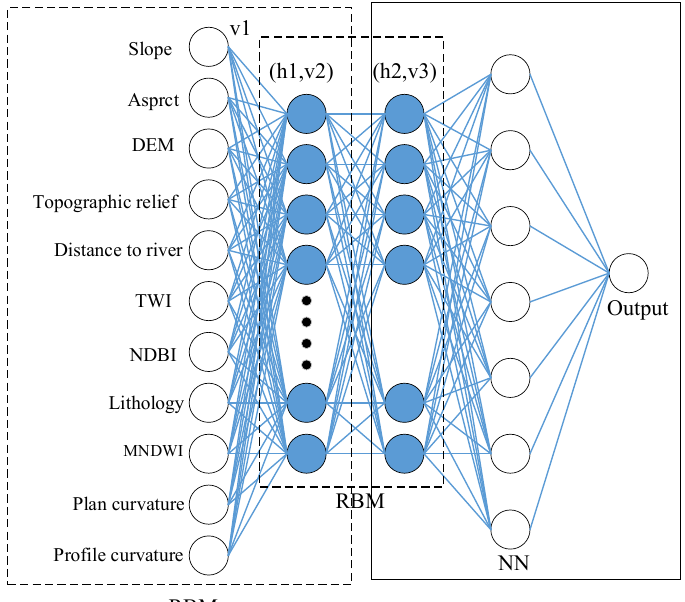
Figure 2. DBN network.